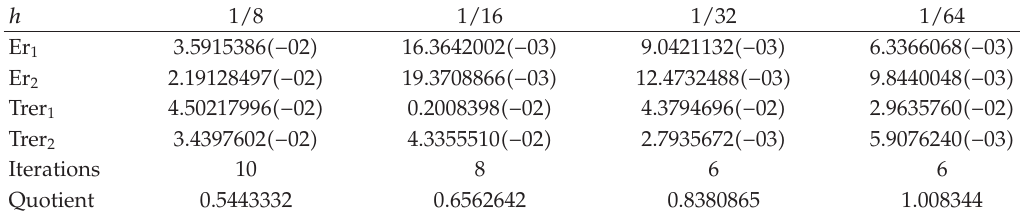
Table 5: Results on the L -shaped region without a posteriori estimates as a stopping criteria.